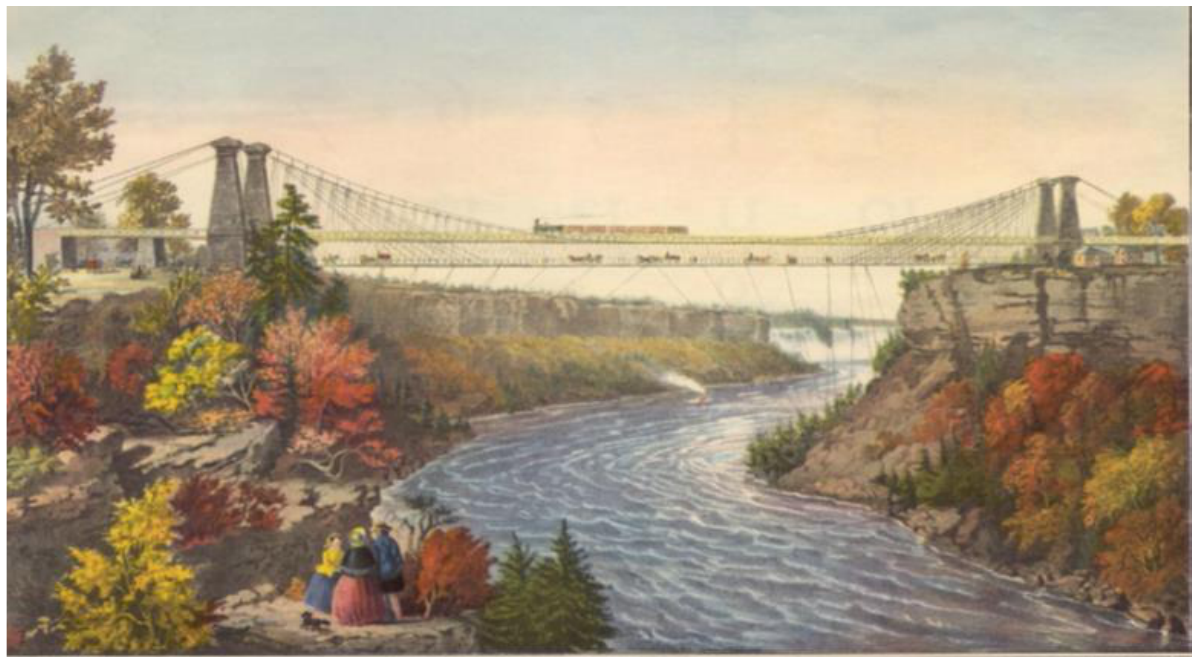
Figure 20. Bridge over Niagara Falls. General view of the structure that allows the upper passage of trains and takes advantage of the interior of the box girder for the passage of carriages and pedestrians. Designed by J.A. Roebling, United States, 1851. Source: (Watercolour) Historical material made public through the prints and photographs division of the Library of Congress under the digital ID cph.3b51175.